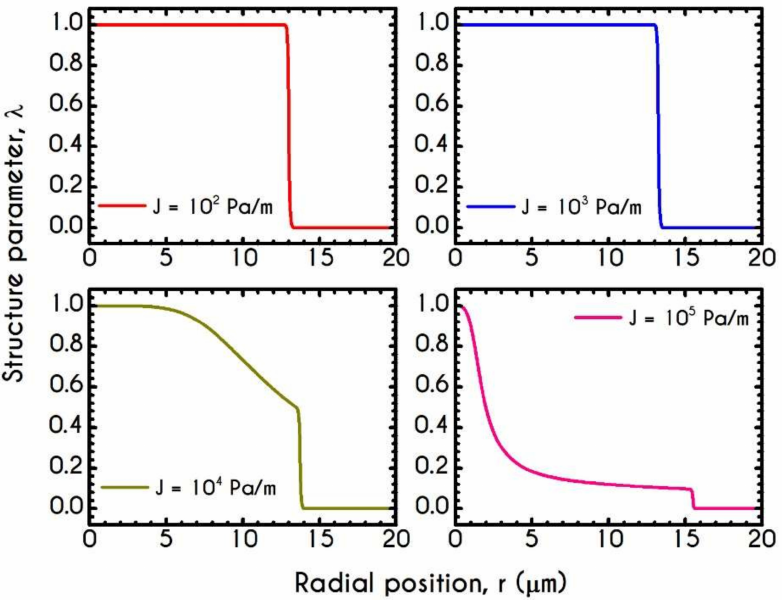
Figure 16. Distribution of the structure parameter λ along the radial position for different pressure gradients J equal to 10 2 Pa/m, 10 3 Pa/m, 10 4 Pa/m, and 10 5 Pa/m, for R = 20 µ m and H c =